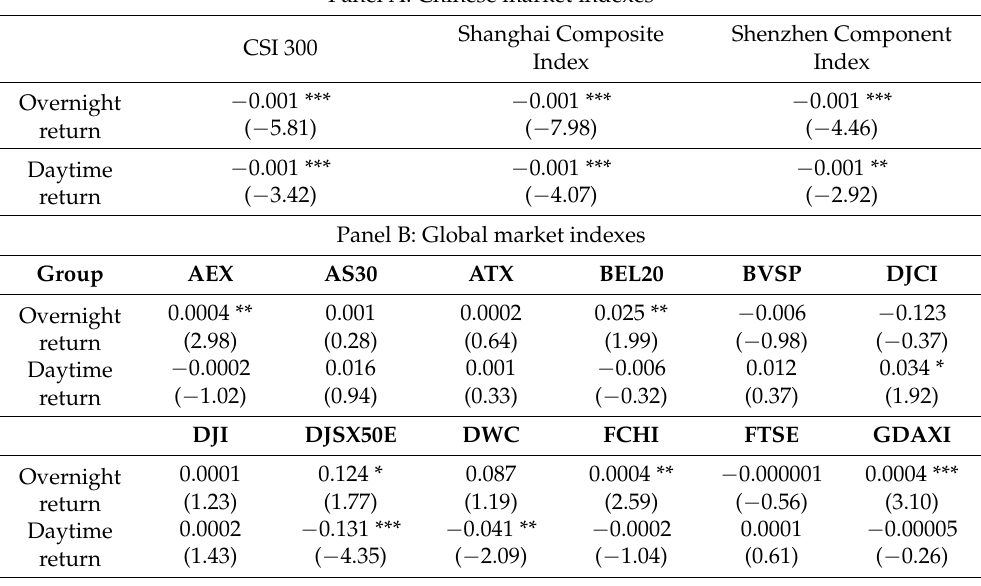
Table 2. Tests for the overnight return anomaly in global markets. Table 2 presents the overnight and daytime return of Chinese market indexes (Panel A) and international market indexes (Panel B) from 2007 to 2021. Country and regional information on the selected international market indexes is presented in Appendix A. Panel A: Chinese market indexes Shanghai Composite Shenzhen Component CSI 300 Index Index